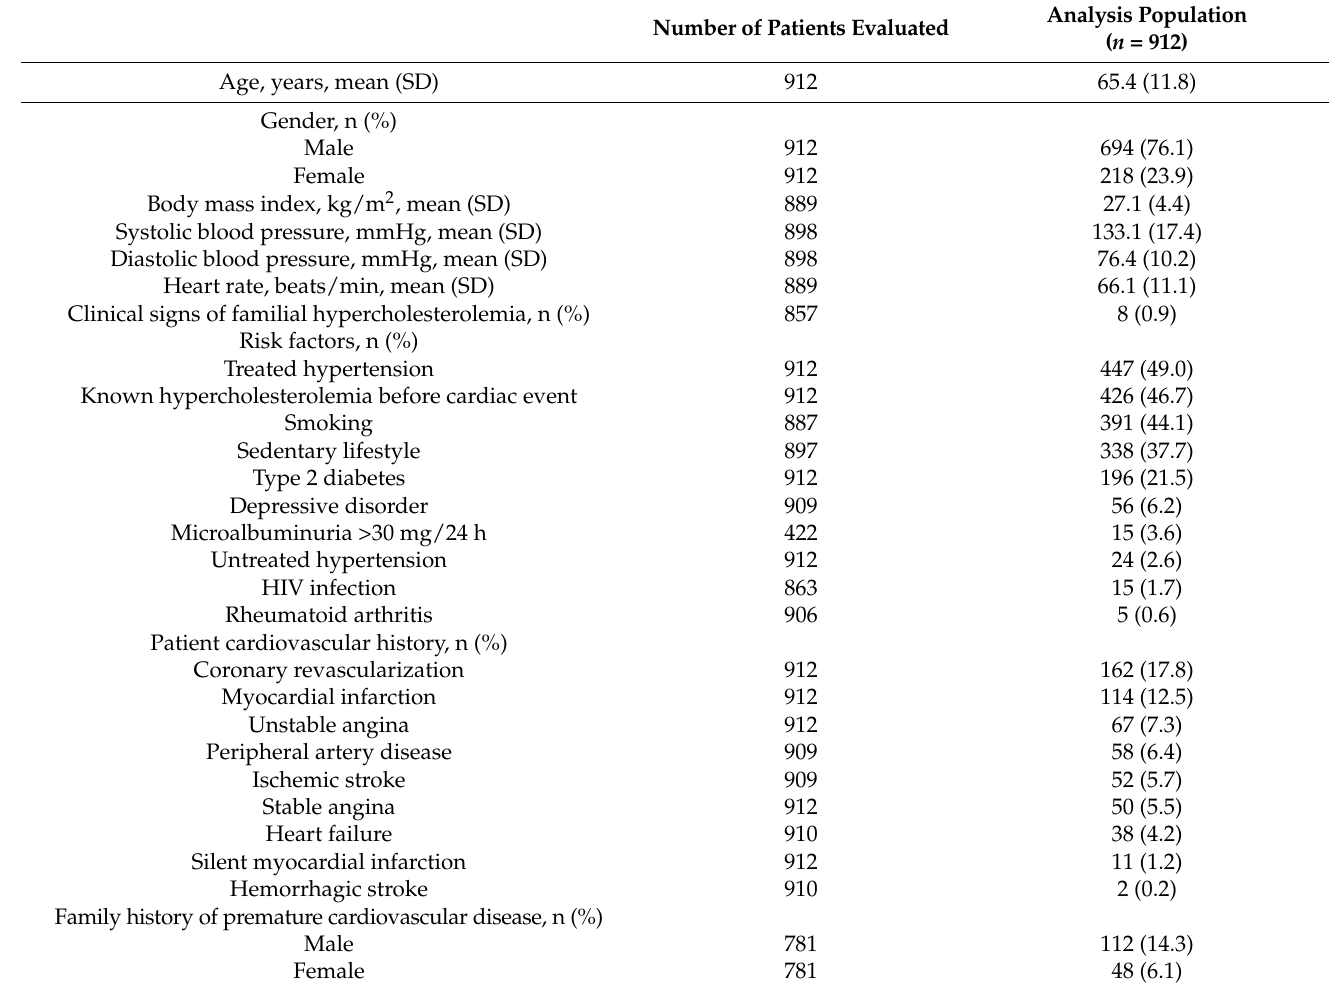
Table 1. Characteristics of very high-risk CAD patients included in the study. Number of Patients